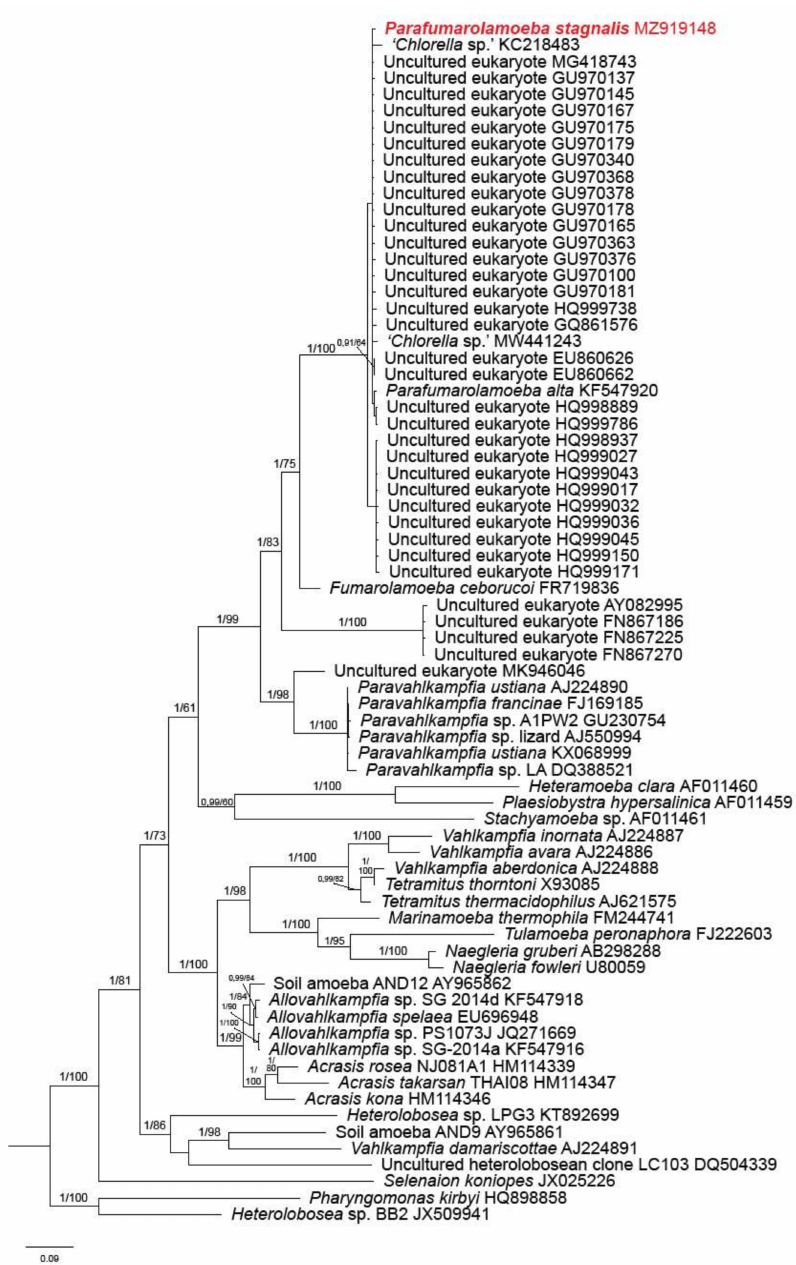
Figure 4. Bayesian phylogeny of the SSU rRNA gene. Bayesian posterior probabilities and Maximum Likelihood (TIM2+F+R4 model) bootstrap values are indicated at branches (values >0.9/>60 are shown; dt—different topology). Pharyngomonas kirbyi HQ898858 SD1A and Heterolobosea sp. BB2 JX509941 were used as the